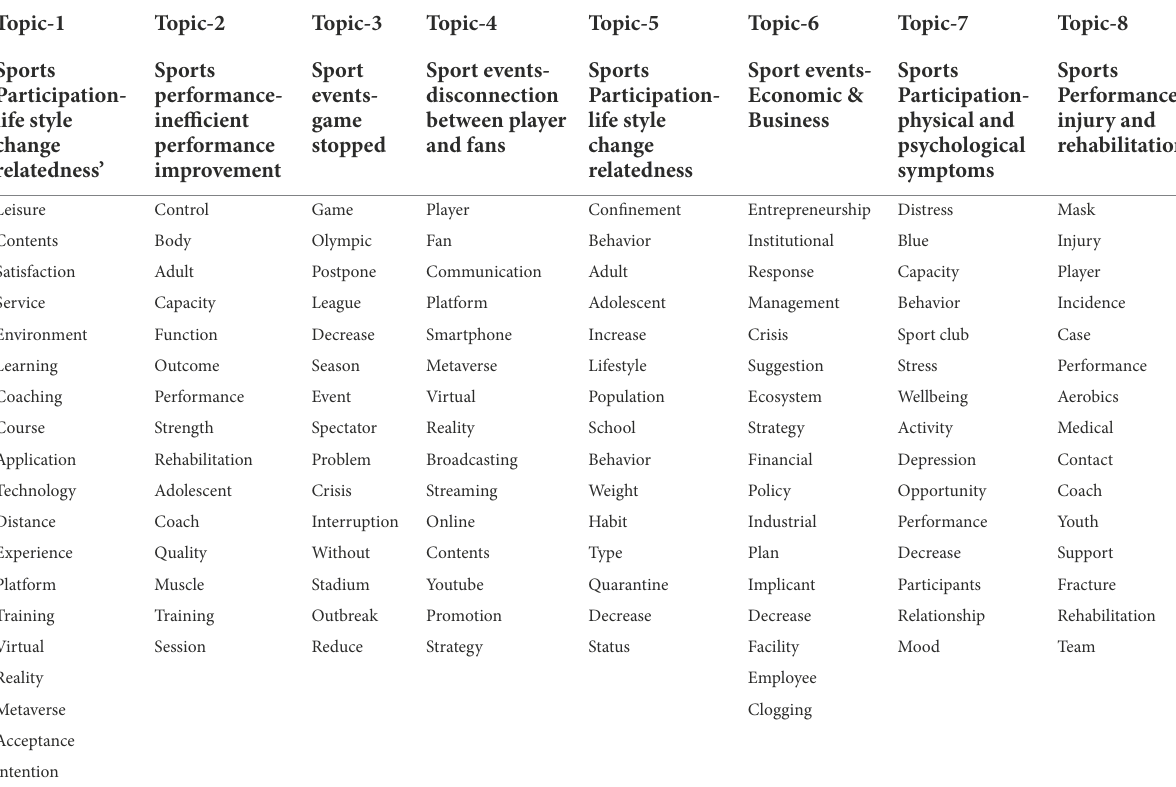
TABLE 1 Result of topic